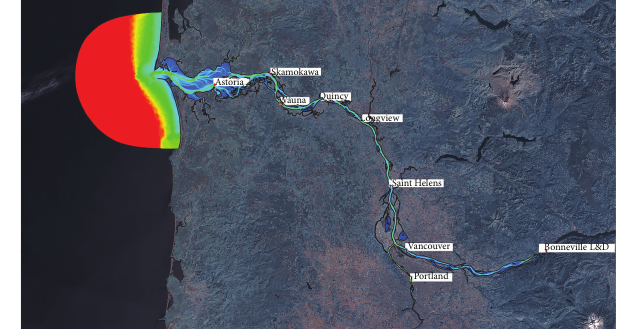
Figure 1: Model domain and observation